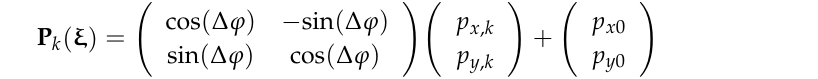
. Figure 5. The reference magnetic field strength value from bilinear interpolation at P k k